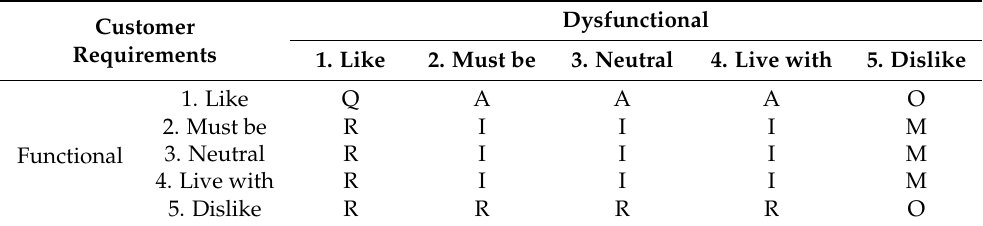
Table 1. Kano evaluation